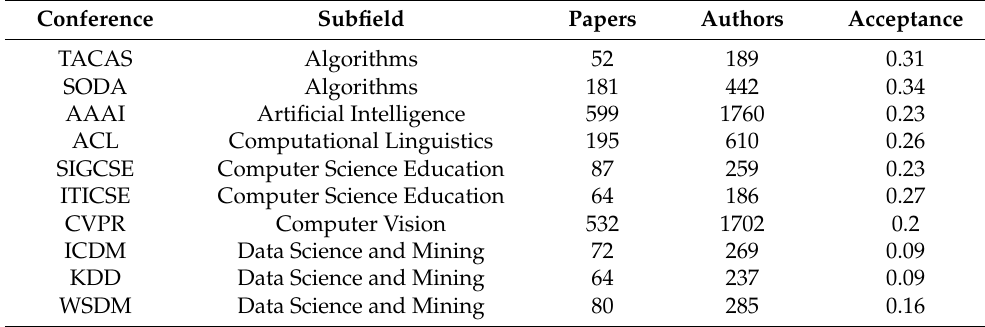
Table 1. All conferences, ordered by subfield and acceptance